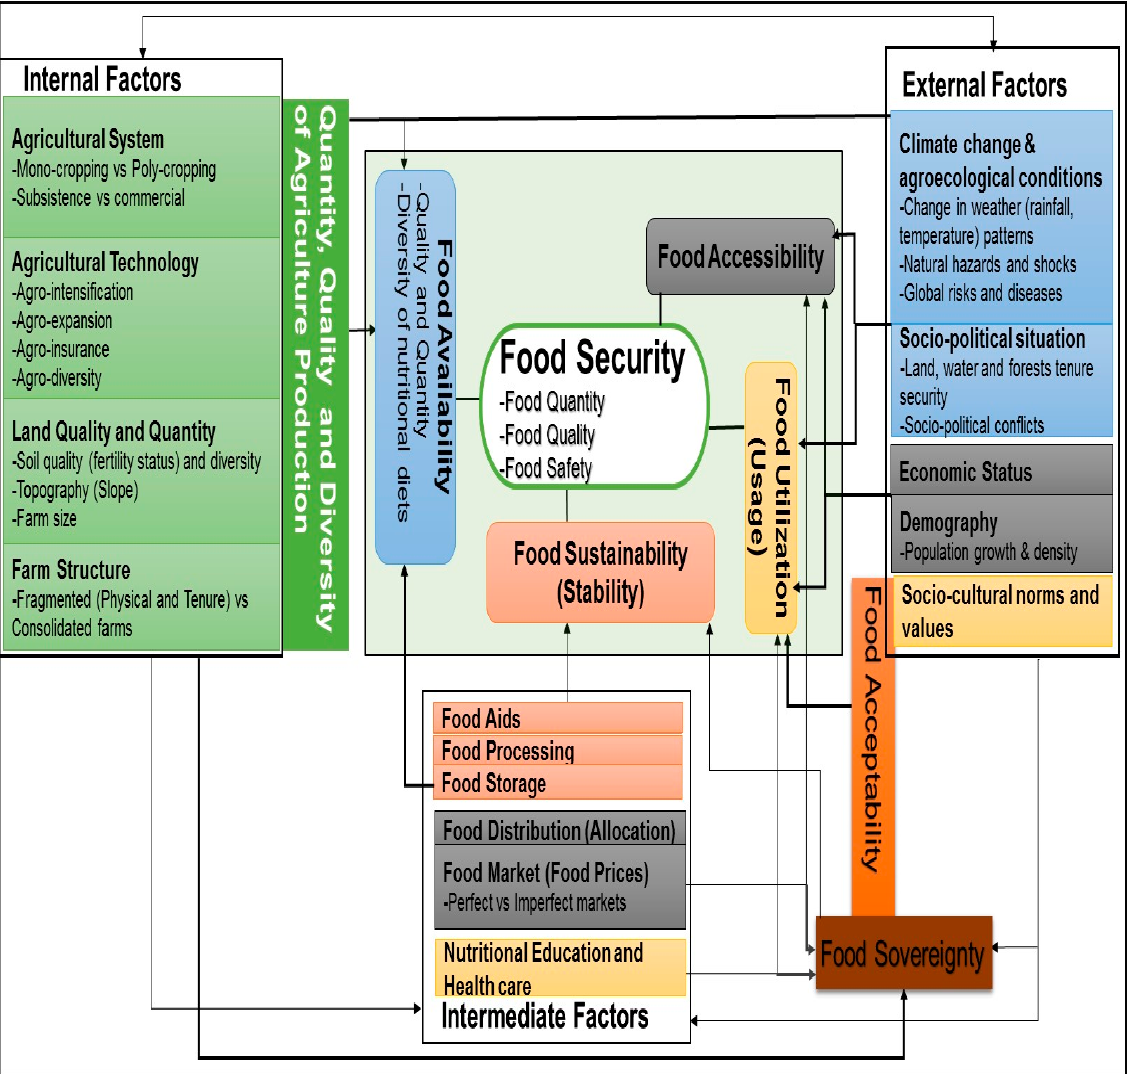
Figure 3. The multidimensionality of food security as influenced by internal and external factors. Source: Developed from the reviewed literature